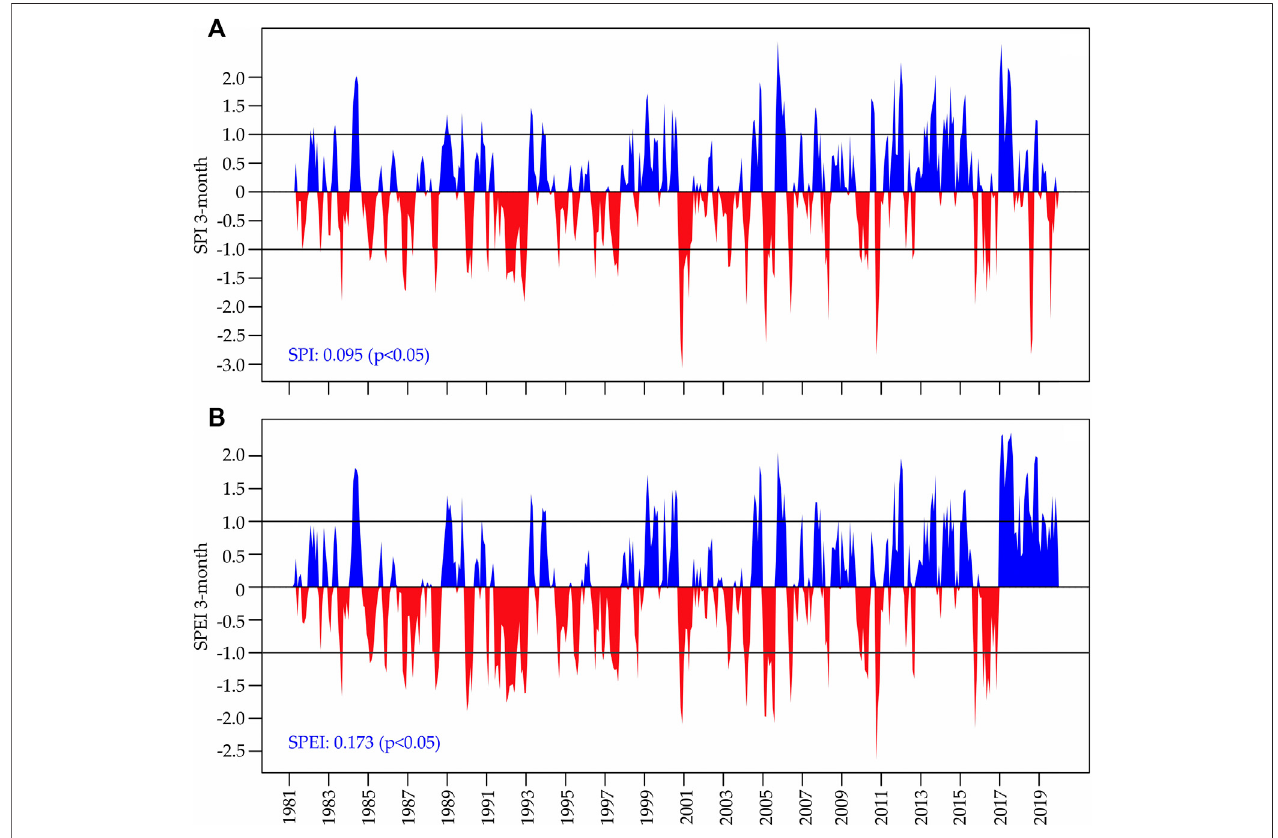
FIGURE 4 | SPI 3-months (A) and SPEI 3-months (B) for the 1981 – 2019 period with wet, normal and drought bands. The amount of change (including the statistical signi fi cance) for each index is shown at the left bottom of each subgraphic.